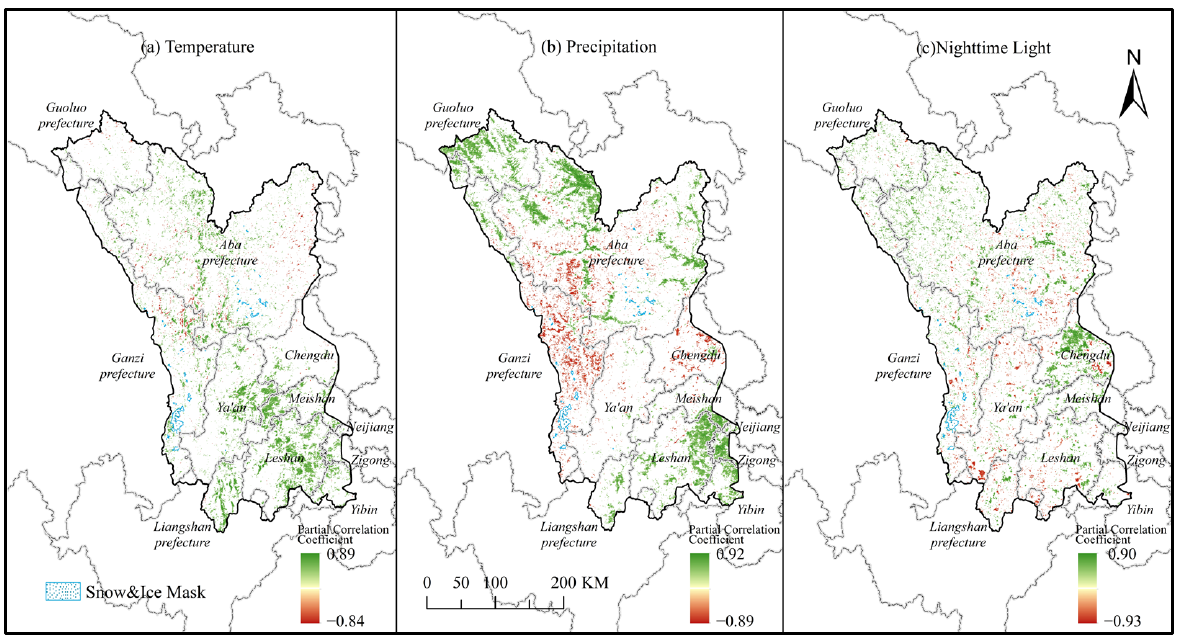
Figure 10. Partial correlation coefficient between NDVI and temperature, precipitation and nighttime light in the growing season in the Minjiang River Basin from 2001 to 2020.